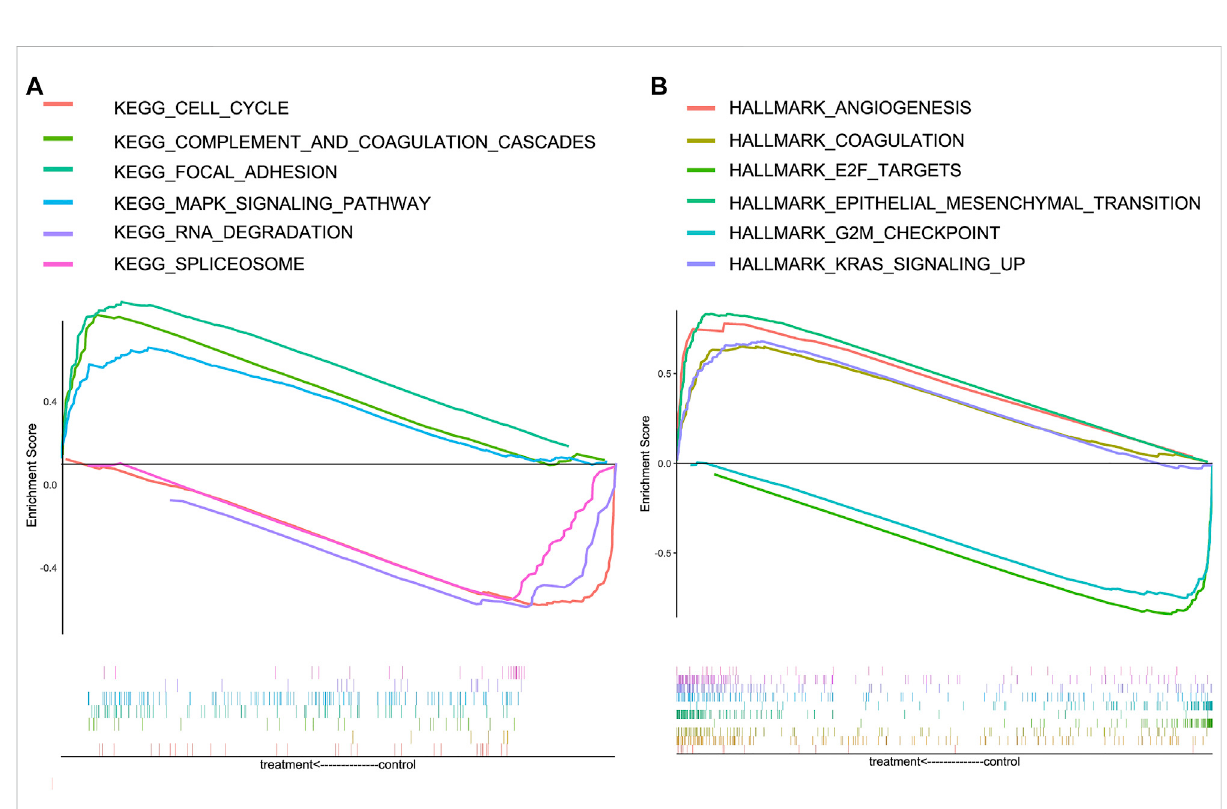
FIGURE 6 Gene Set Enrichment Analysis (GSEA) for high-risk and low-risk groups in the KEGG and HALLMARK datasets. (A) Enrichment pathways in the KEGG dataset of high-risk and low-risk groups. (B) Enrichment pathways in HALLMARK dataset of high-risk and low-risk